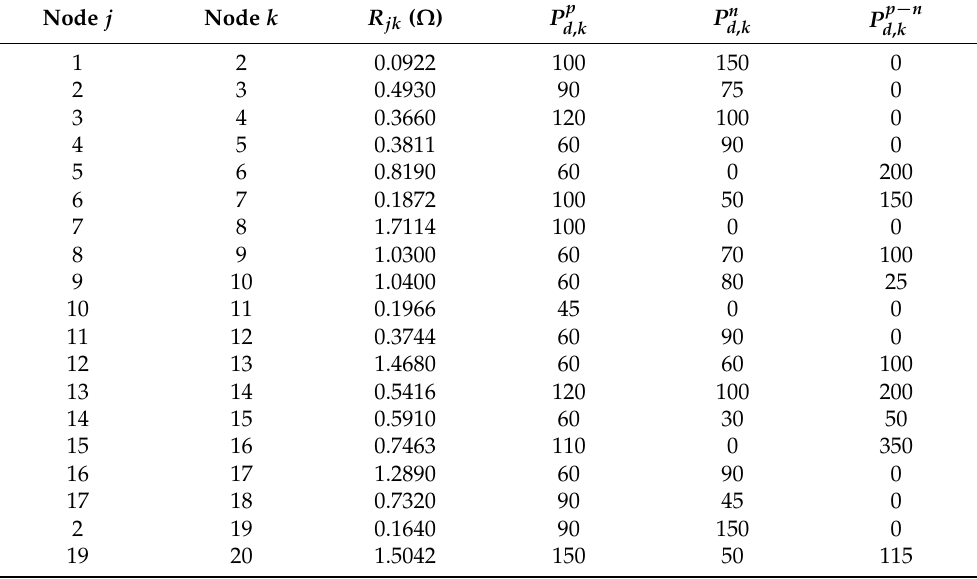
Table 3. Parametric information regarding the 33-bus grid (all powers in